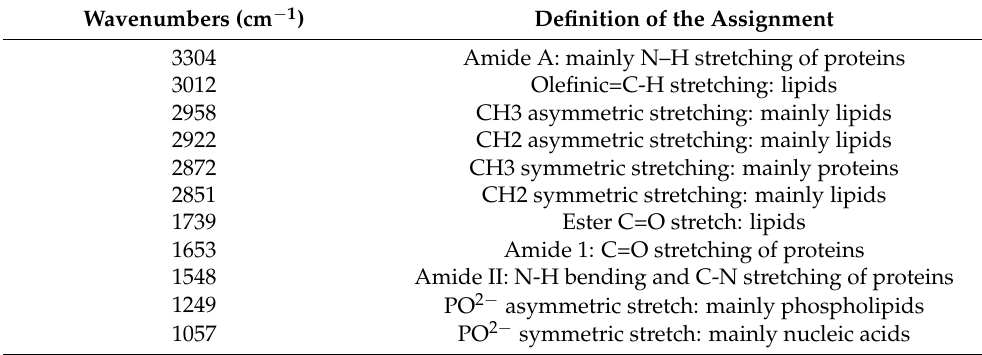
Table 4. FTIR spectra general peak assignments of brain tissue in 4000–500 cm − 1 spectral range according to the literature